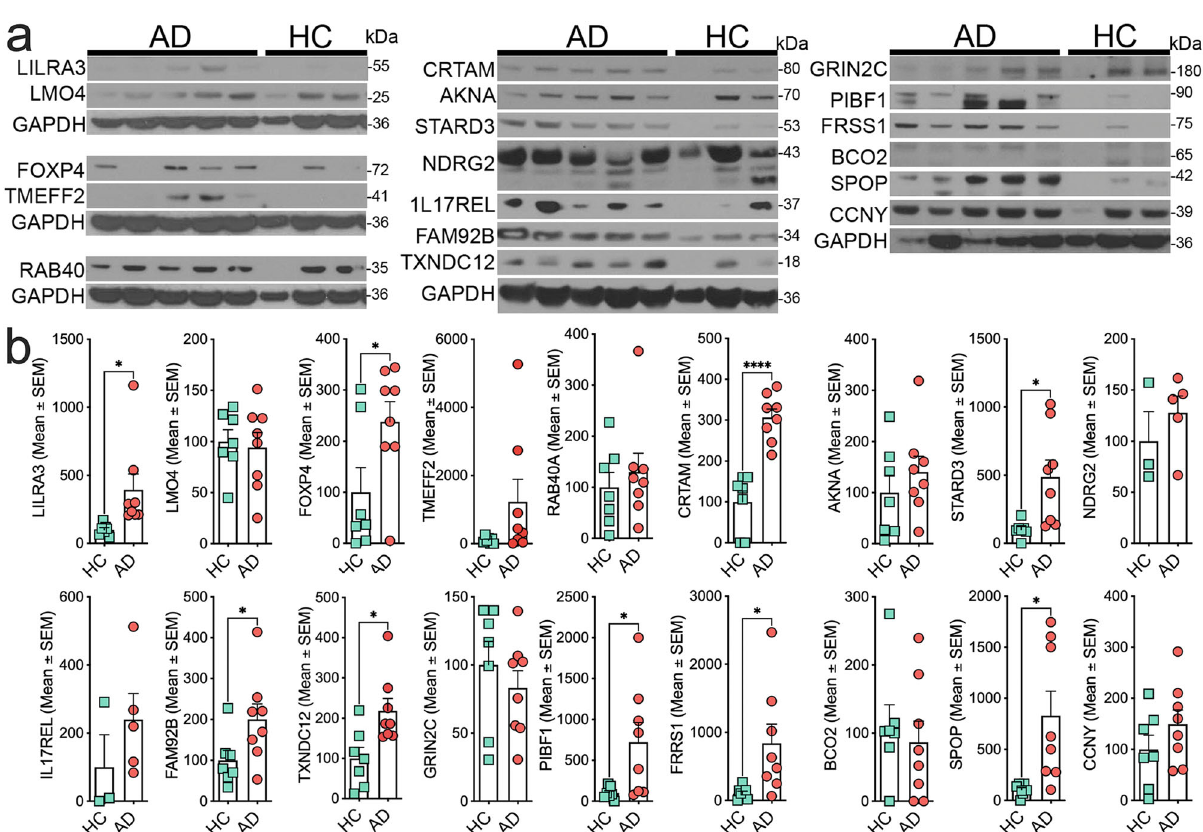
Fig. 4 Nine proteins relevant to in fl ammation, transcription regulation, and metabolism are signi fi cantly increased in post-mortem autopsy brains of human sporadic Alzheimer ’ s disease. a , b . Western blot and quanti fi cations showing signi fi cantly elevated levels of predicted proteins relevant to in fl ammatory pathways (PIBF1, CRTAM, FRRS1, and LILRA3), transcriptional regulation (FOXP4 and SPOP), metabolism (PIBF1 and STARD3), and others (TXNDC12 and FAM92B) in post-mortem temporal cortical samples of sporadic AD compared to age-matched healthy controls (HC). Note that SCGB3A1 and SLC44A2 were not detectable. Individual gels are separated and aligned with their corresponding loading control (GAPDH). The middle gel was stripped and reprobed accordingly. (Raw blots are shown in Supplementary Fig. 10). Data shown are mean ± s.e.m of ratio to consecutive loading control GAPDH; signi fi cance was determined using two-tailed t tests Welch-corrected; * p < 0.05; ** p < 0.01, ( P values for FRRS1 = 0.0340, STARD3 = 0.0176, PIBF1 = 0.0363, TXNDC12 = 0.0122, FAM92B = 0.0456, FOXP4 = 0.0474, SPOP = 0.0183, CRTAM = < 0.0001, and LILRA3 = 0.0392) n = 7 healthy controls and n = 8 sporadic